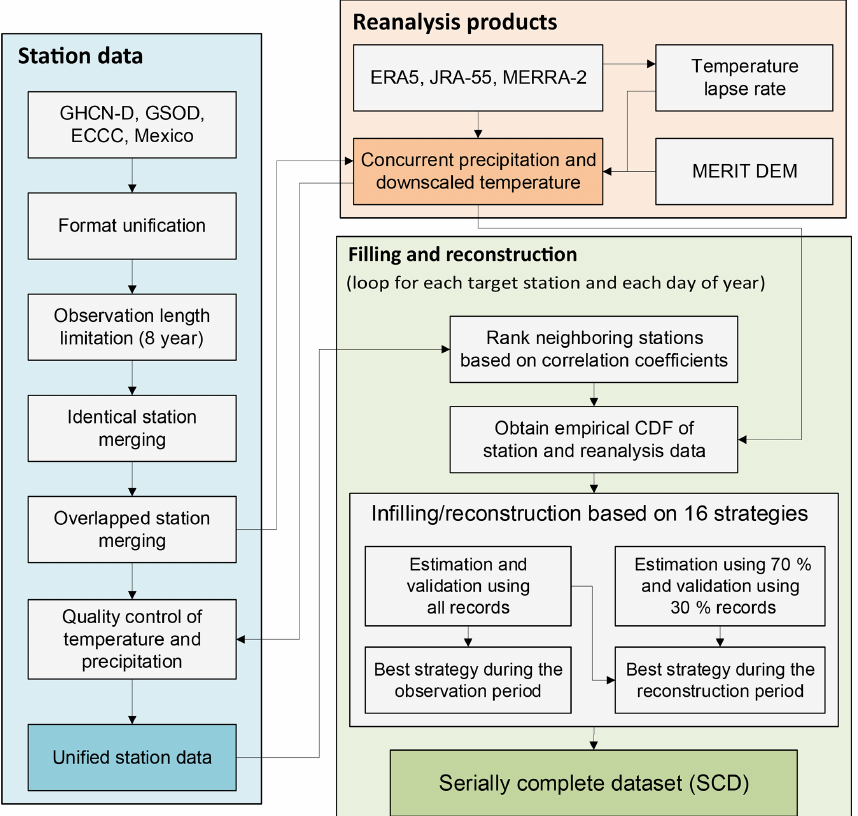
Figure 4. Flowchart of the production of the SCDNA, including station data preparation, reanalysis product processing, and missing data infilling and